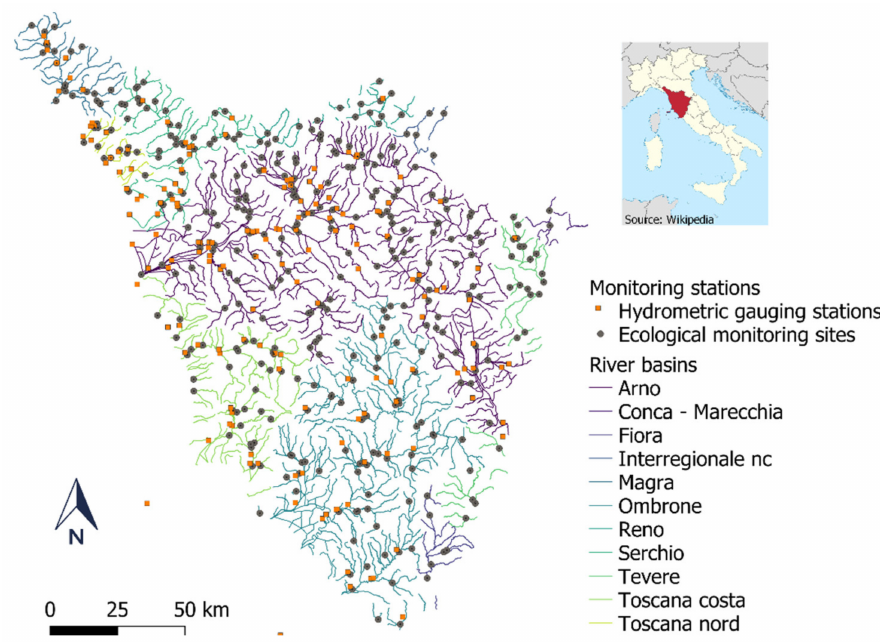
Figure 1. Map of the river network of the catchments in Tuscany, hydrometric gauging stations (SIR), and ecological monitoring sites